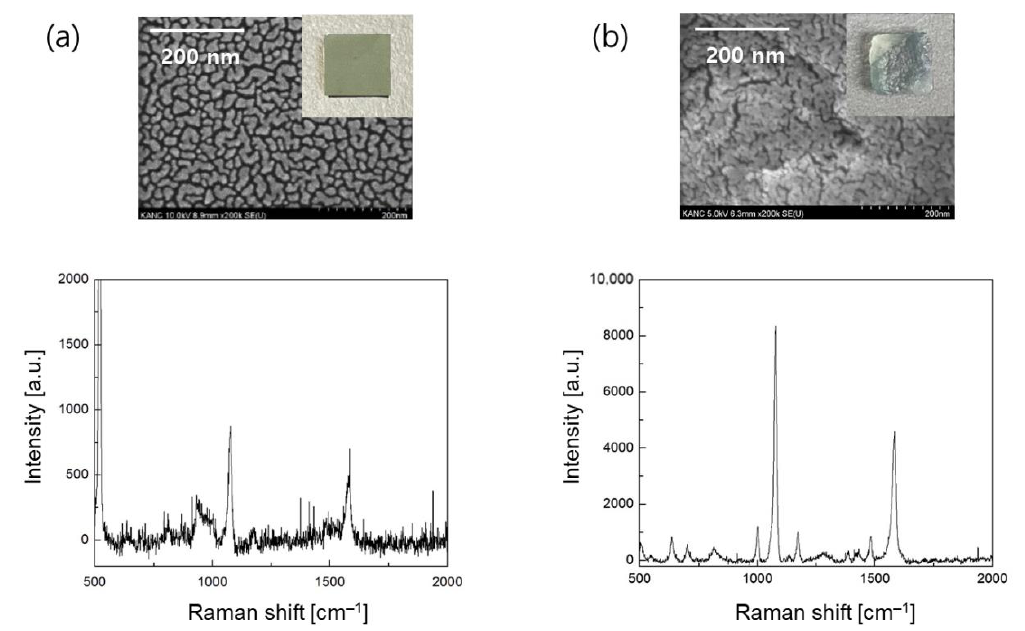
Figure 4. SERS sensor platform with a gold nanostructure. ( a ) FE-SEM image of a silicon wafer with gold nanostructures with a thickness of 3 nm and SERS experiments of 4-ABT analytes at a concentration of 10 µ M. The sharp and intense Raman peak at 520 cm −1 originated from the crystalline silicon wafer. ( b ) FE-SEM image of a silk-based SERS sensor with gold nanocracks on a porous silk substrate and SERS experiments of 4-ABT analytes at a concentration of 10 µ M.